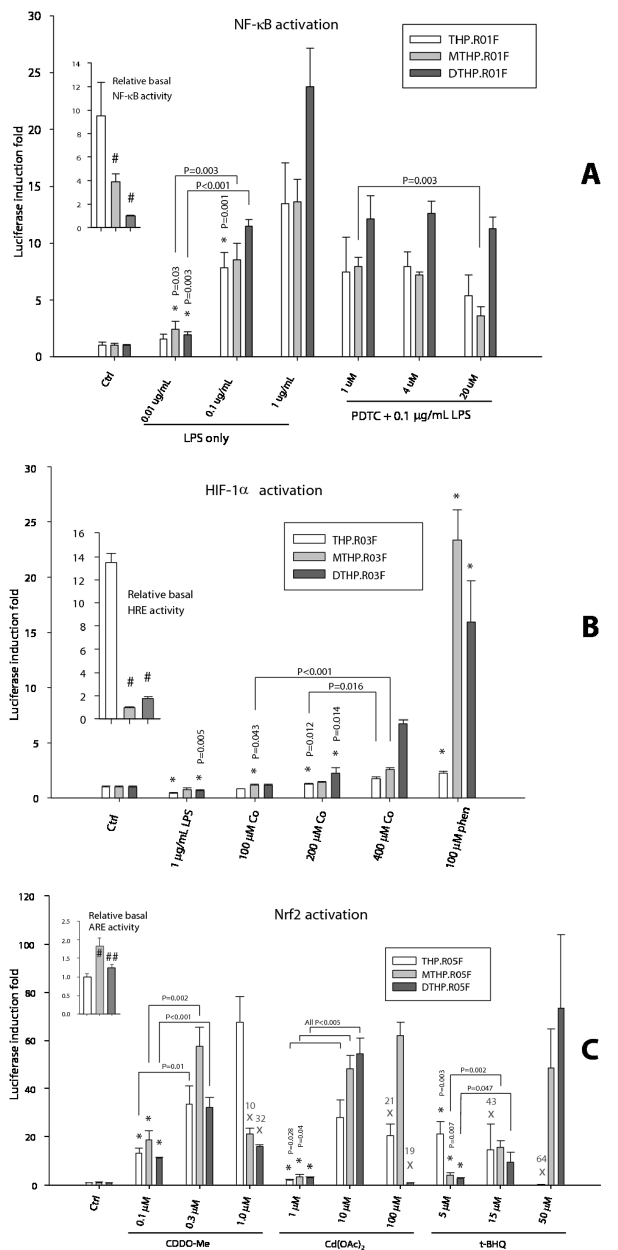
Figure 5. Differentiation of monocytic THP.R0nF pathway reporters into macrophages or dendritic cells retains the reporter activity. ( A ) Monocytes THP.R01F were differentiated into macrophages (MTHP.R01F) and DCs (DTHP.R01F) and then treated, in triplicates, for 4 hours with LPS only or in presence of NF-κB activation inhibitor PDTC. ( B ) THP.R03F, MTHP.R03F, and DTHP.R03F cells were treated, in triplicates, for 16 hours with LPS or hypoxia mimics CoCl and o-phenanthroline. ( C ) The ARE/ 2 EpRE activity in THP.R05F, MTHP.R05F, and DTHP.R05F cells treated, in triplicates, for 16 hours with inducers of Nrf2. The X ’s indicate treatments too toxic to cells and percentages of cell fluorescence loss due to apoptosis/death. Fluorescence of lysates of all treated cells was used as a cell enumeration surrogate. The luciferase activity induction folds for each cell type were normalized to the respective controls. The relative basal TF activities in the untreated controls were normalized to the lowest value and are shown in the insets. The bars and error bars are normalized luminescence means ± SD, n = 3. Statistical analysis in the insets: one-way ANOVA, with pairwise multiple comparisons by Holm-Sidak test. Statistical significance #: compared to white bar; ##: compared to light grey bar; in all cases, P<0.01. Statistical analysis in the main charts: pairwise comparisons by an unpaired t -test. Statistical significance *: the lowest dose treatment compared to respective control; P≤0.001, if not indicated otherwise. doi: 10.1371/journal.pone.0085494.g005 PLOS ONE |